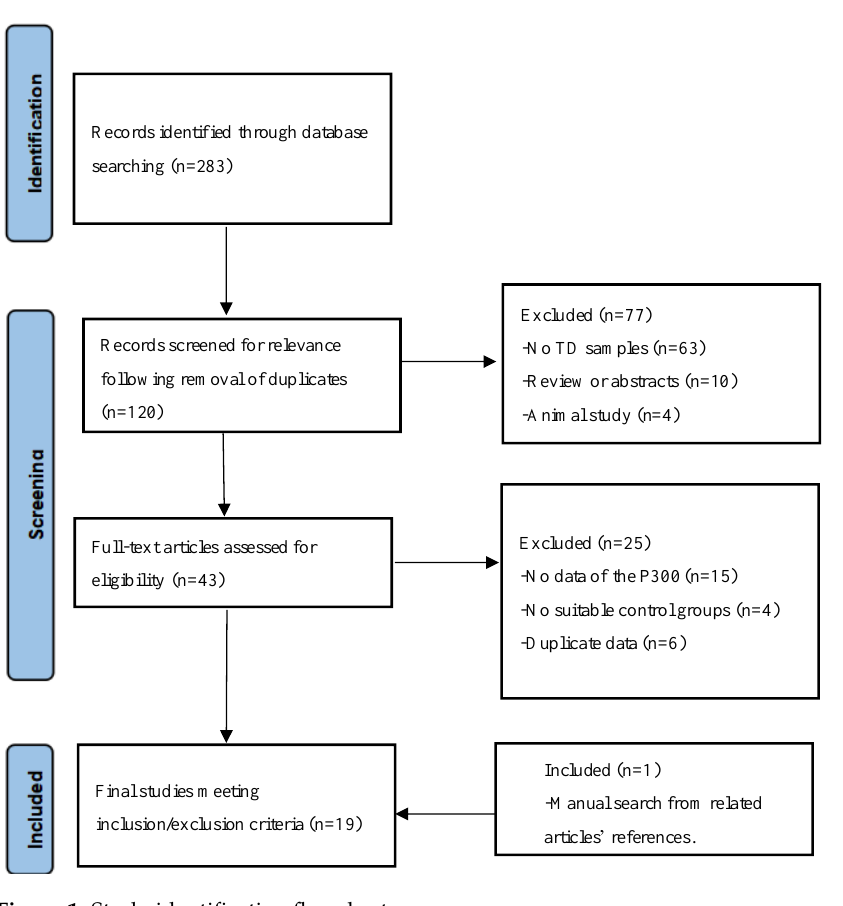
Figure 1. Study identification flowchart.